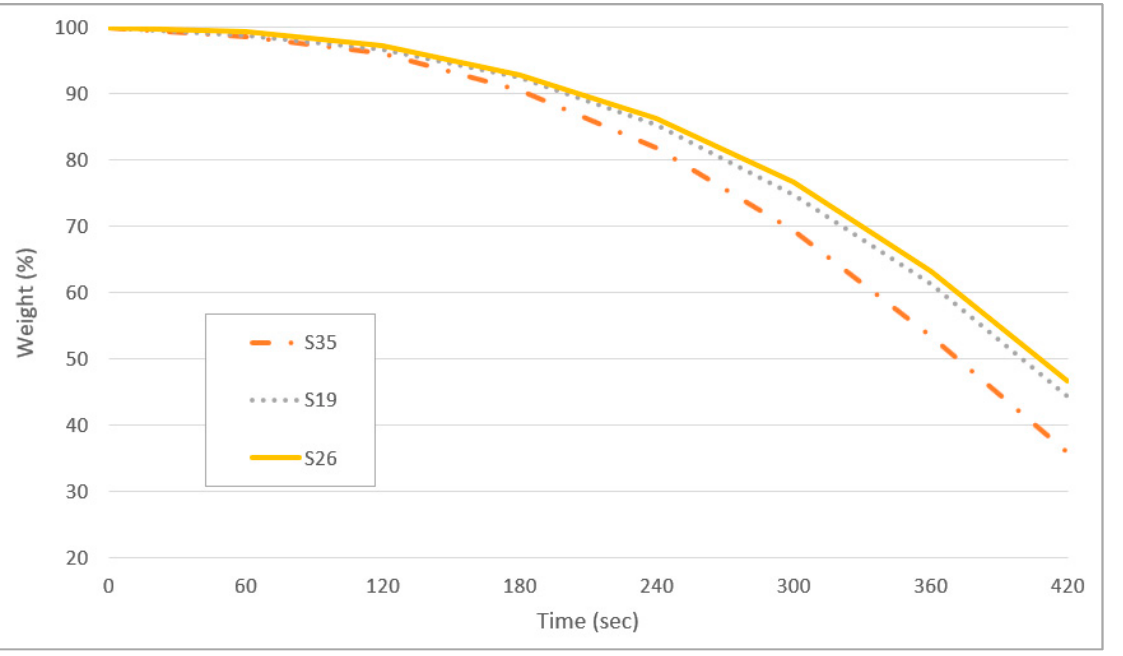
Figure 7. Weight loss as a function of time of sample S35, S19, and S26.